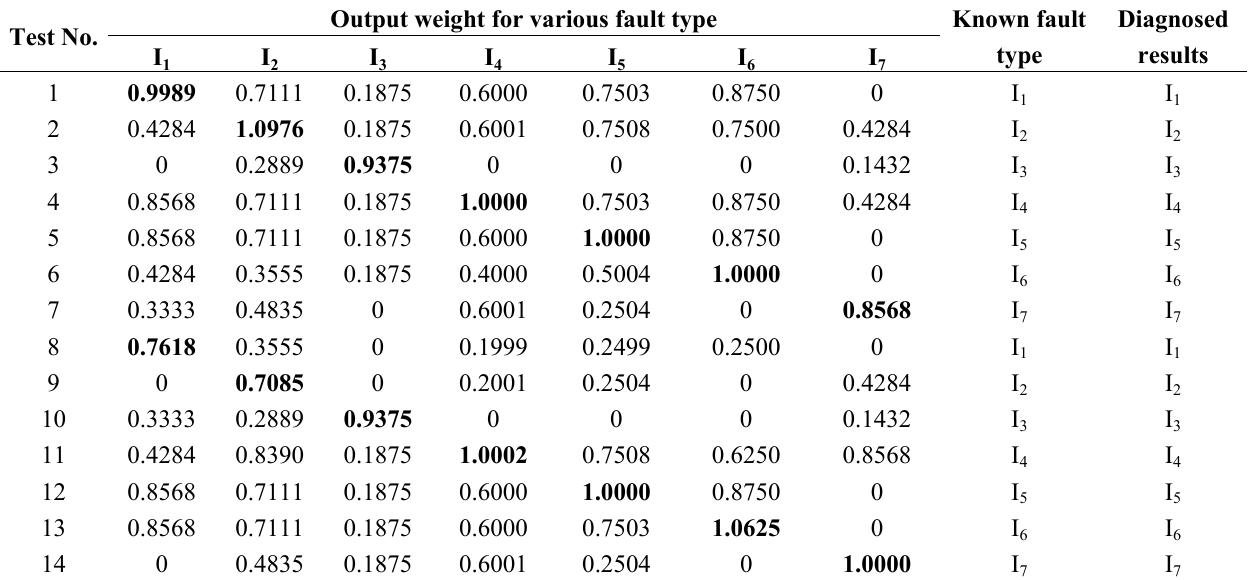
Table 5. Results of the islanding detection method based on a CMAC neural network.